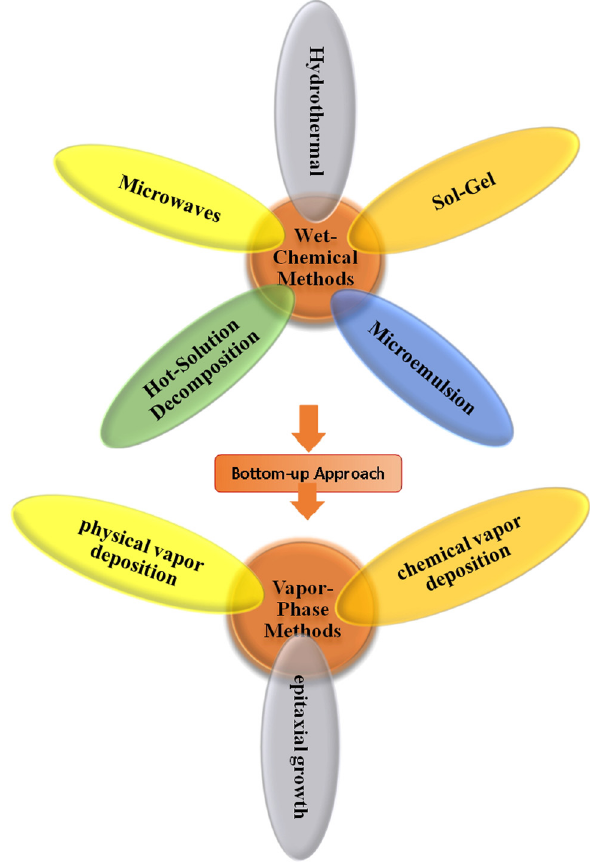
Scheme 5: Bottom - up approach